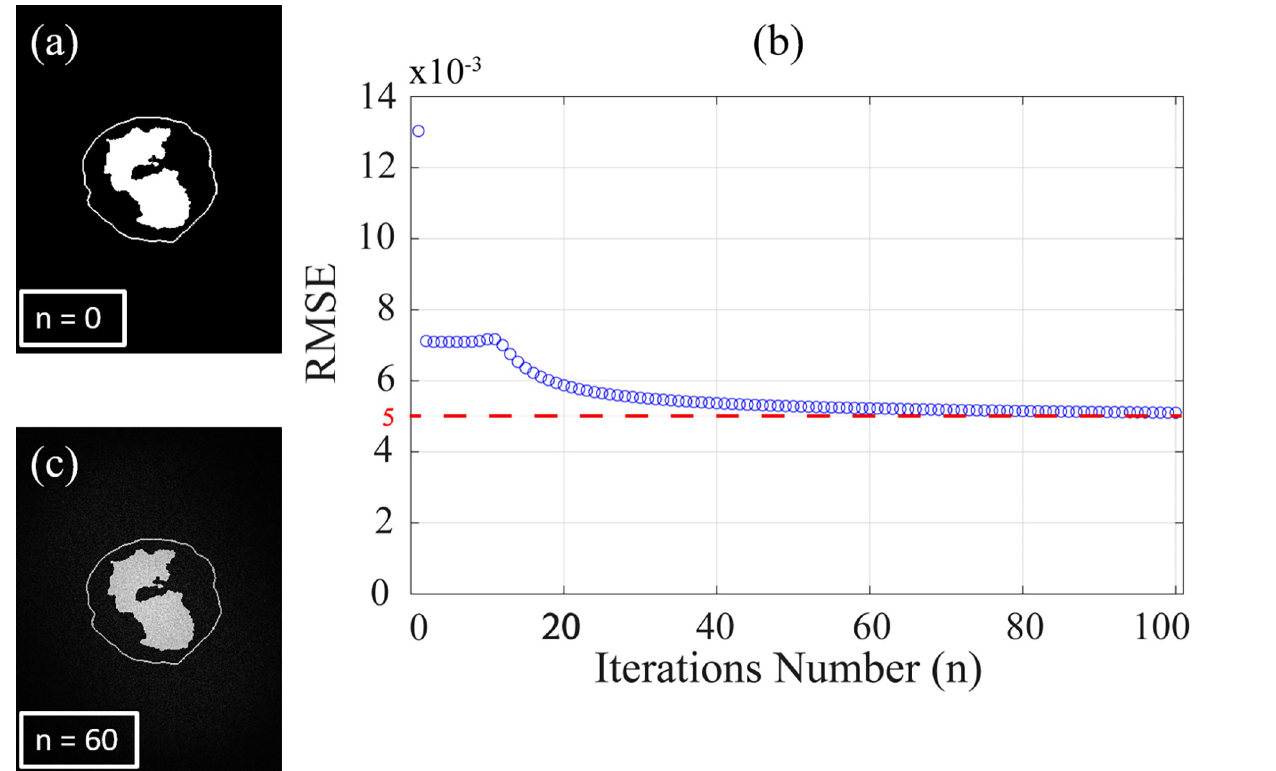
Fig 6. (a) Zero-padded Basophil reference image (image size = 7680 × 4320 pixels), (b) relation between number of iterations (n) and the root mean square error (RMSE), and (c) the numerical reconstruction of Basophil WBC image at n = 60.